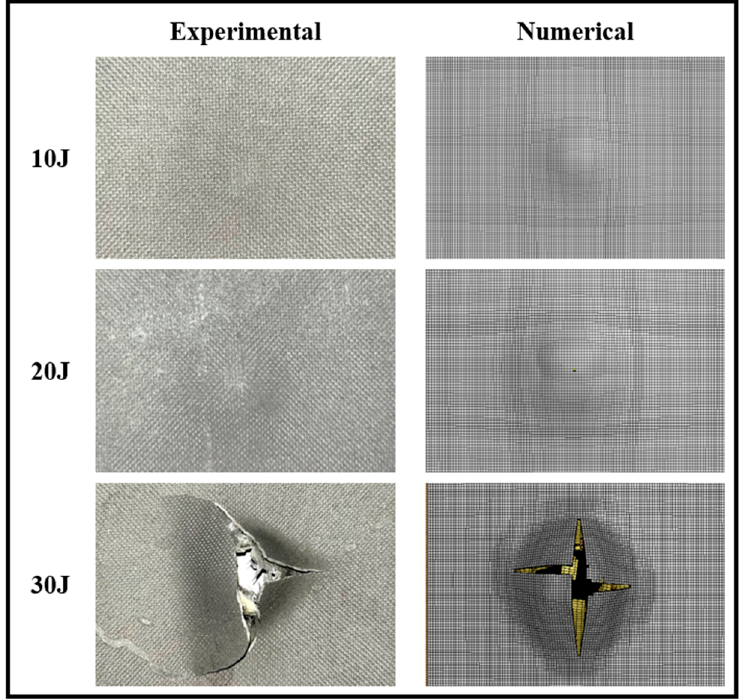
Figure 10. Comparison of the experimental and numerically captured failure modes of the non- impacted surface of 3DFML specimens subjected to different low-velocity impact energies.